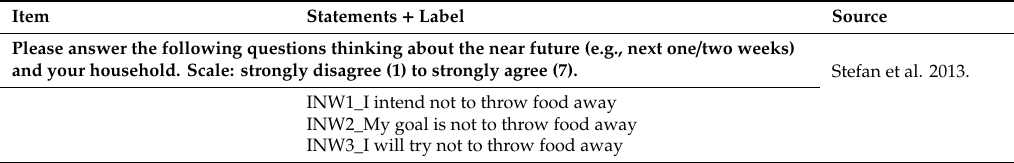
Table A2. Intention not to waste